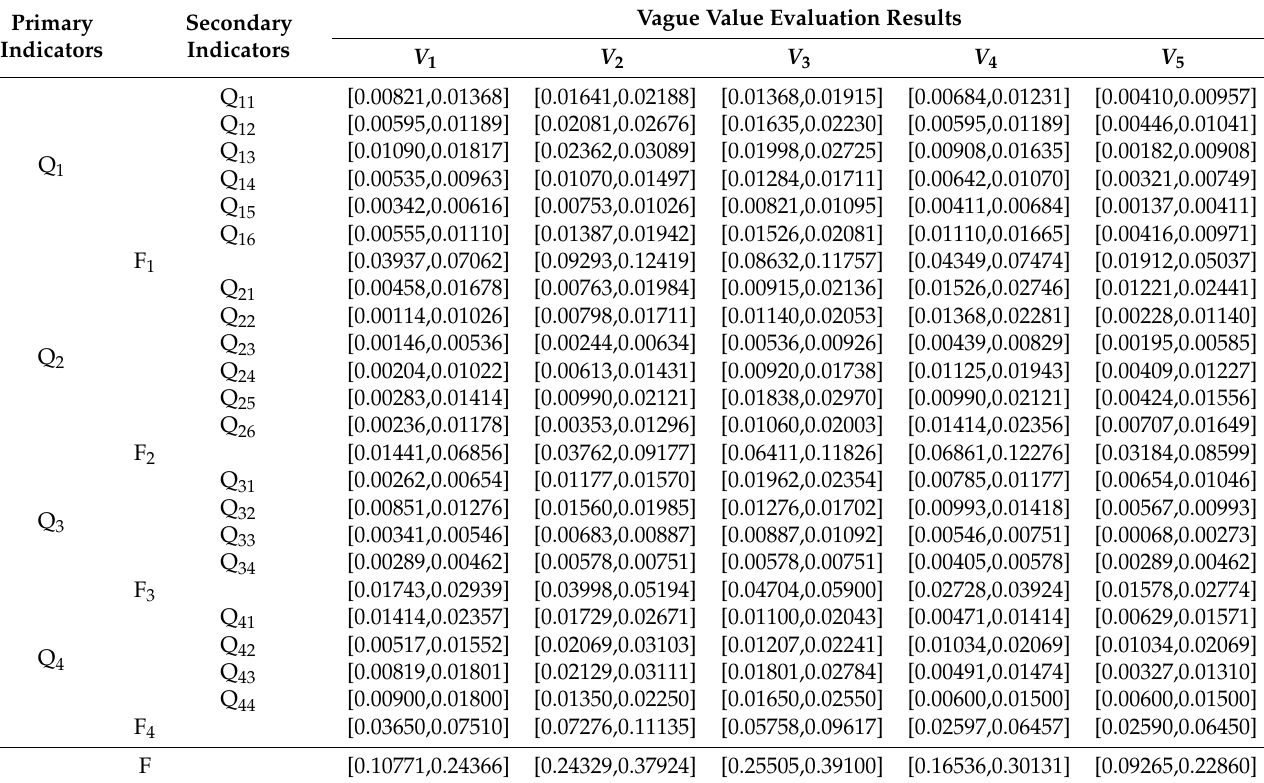
Table 5. Comprehensive evaluation results of the YC vague value comments on vague value.